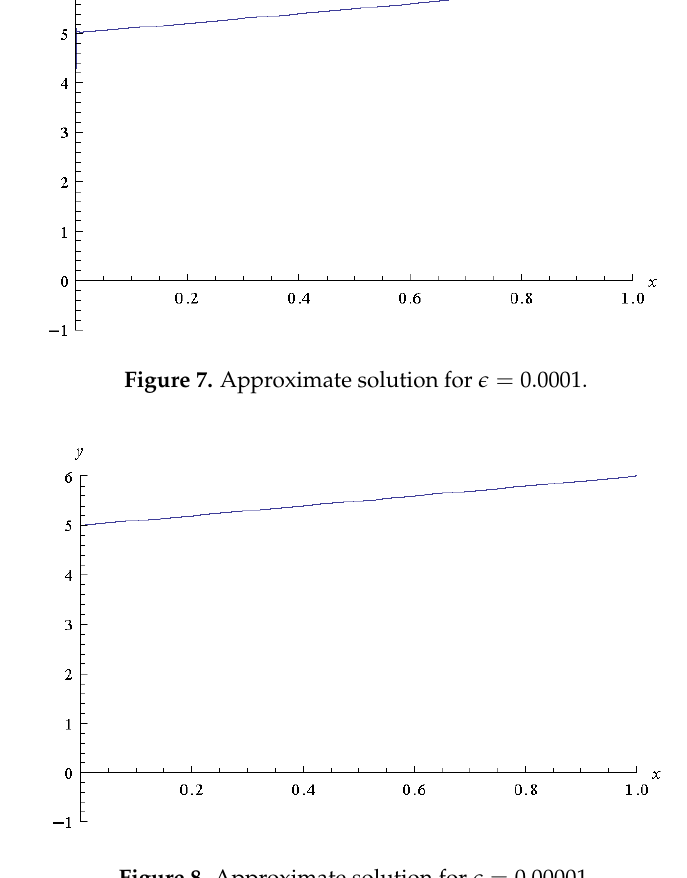
Figure 8. Approximate solution for (cid:101) =